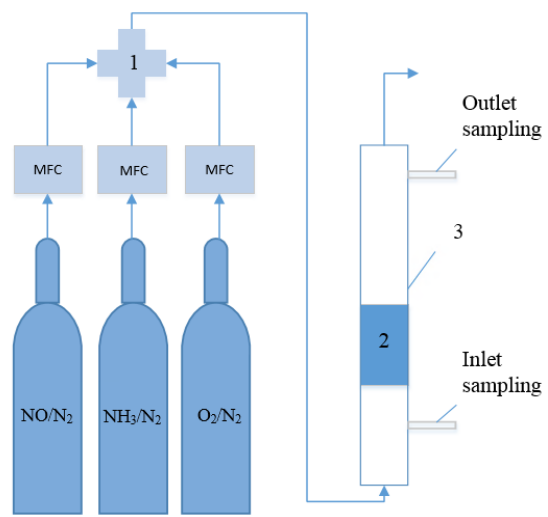
Figure 10. Schematic view of the experimental setup: MFC—mass flow controller; 1—gas collector; 2—catalyst; 3—catalytic reactor.